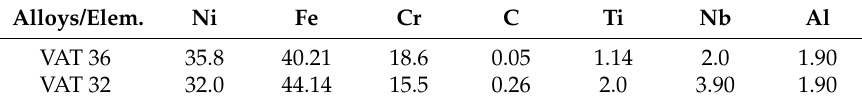
Table 1. Hemical compositions: VAT 36 and VAT 32. (Mass.%). Table 1. Chemical compositions: VAT 36 and VAT 32. (Mass.%).